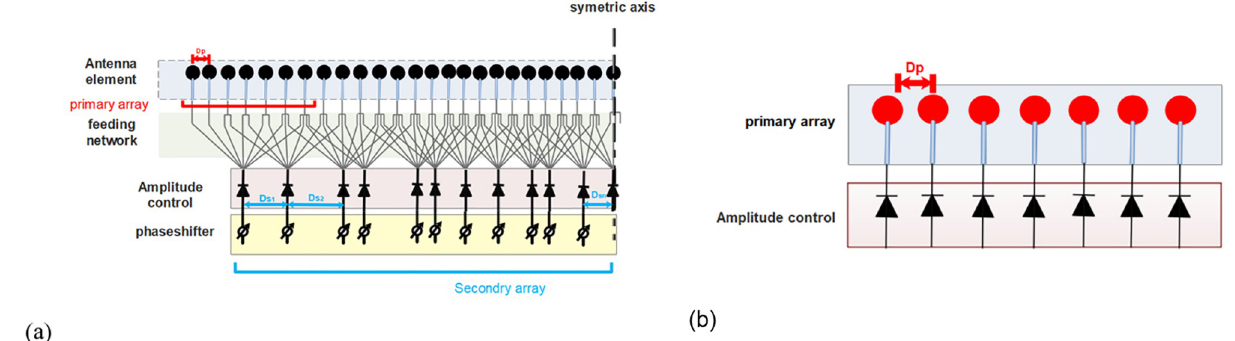
Fig 3. (a) Symmetrical randomly overlap subarray with beam forming unit and amplitude and phase control units ( N Uniform primary array groups with equal spacing D p = λ /2 and symmetrical amplitude control.